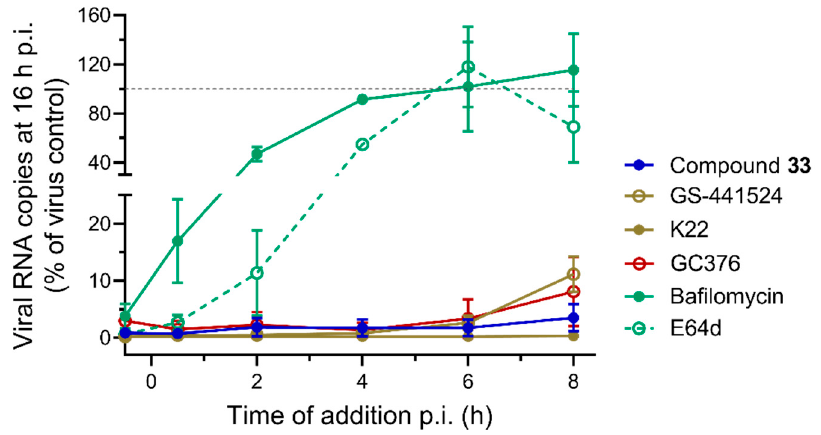
Figure 3. One-cycle TOA experiment in HCoV-229E-infected HEL cells. Compounds and concentra- tions: 1,4,4-trisubstituted piperidine analogue 33 at 15 µ M; inhibitors of virus entry: E64d (15 µ M) and bafilomycin (0.00625 µM); M pro inhibitor GC376 (25 µM); and inhibitors of viral RNA synthesis: GS-441524 (20 µM) and K22 (15 µM). Data points are the mean ± SEM (N = 3 for 33 and N = 2 for the reference compounds). The cells were exposed to the compounds at the indicated time points, infected at time point zero, and lysed at 16 h p.i. The Y-axis shows the number of intracellular viral RNA copies, determined by RT-qPCR and expressed relative to the value in the virus control (=set at 100%; dashed grey